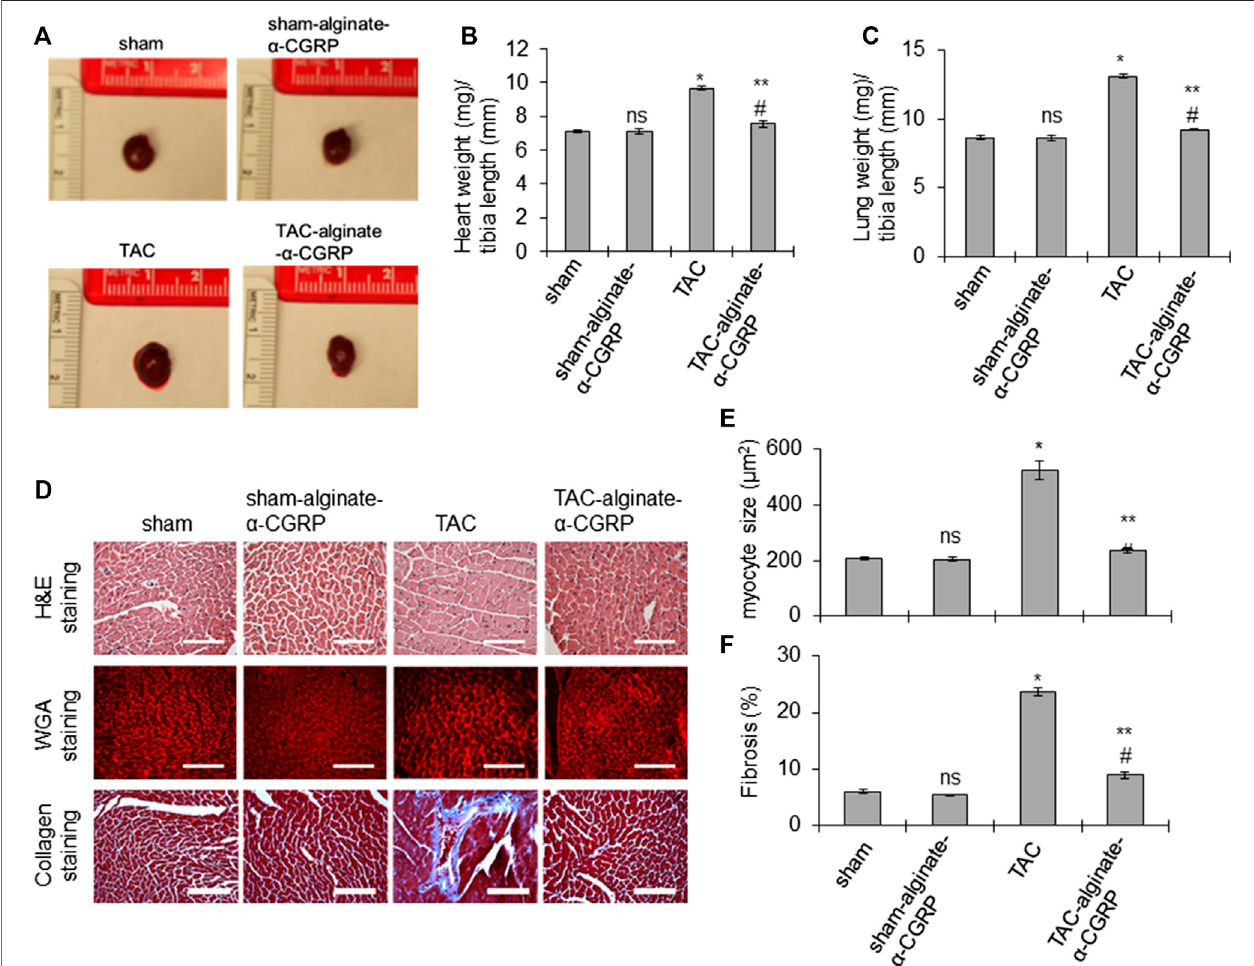
FIGURE 4 | Alginate- α -CGRP microcapsules delivery in two-day post-TAC mice reduces TAC-induced cardiac hypertrophy and fi brosis. (A) Representative imagesshowingthesizeoftheheartsafter28 daysofdeliveryofalginate- α -CGRP microcapsules. (B , C) Bardiagramsshowingtheratioofwetheartweight/tibia length, and wet lung weight/tibia length. (D) The paraf fi n-embedded LV sections were stained with H&E, WGA stain, and trichrome-collagen stain. Scale bar, 100 μ m. WGA stained sections were used to measure cardiomyocyte size in LVs by the NIH-ImageJ software and plotted (E) . LV collagen content, an indicator of fi brosis, was quantitatedbytheNIH-ImageJsoftwareandplotted (F) .Valueswereexpressedasthemean ± SEM.* p < 0.05,TACvssham;** p < 0.05,TAC-alginate- α -CGRPvsTAC; # p > 0.05, TAC-alginate- α -CGRP vs sham; ns, non-signi fi cant compared to sham.